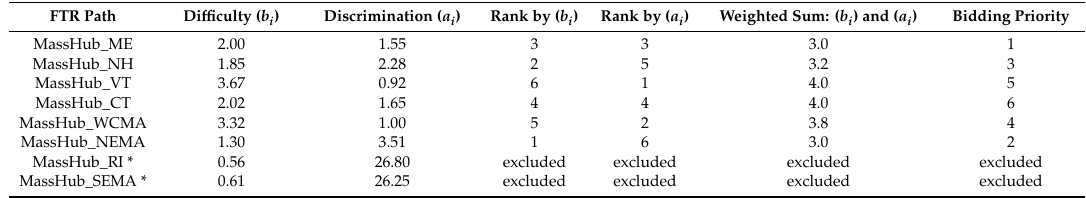
Table 3. Evaluation processes to determine bidding priority among FTR